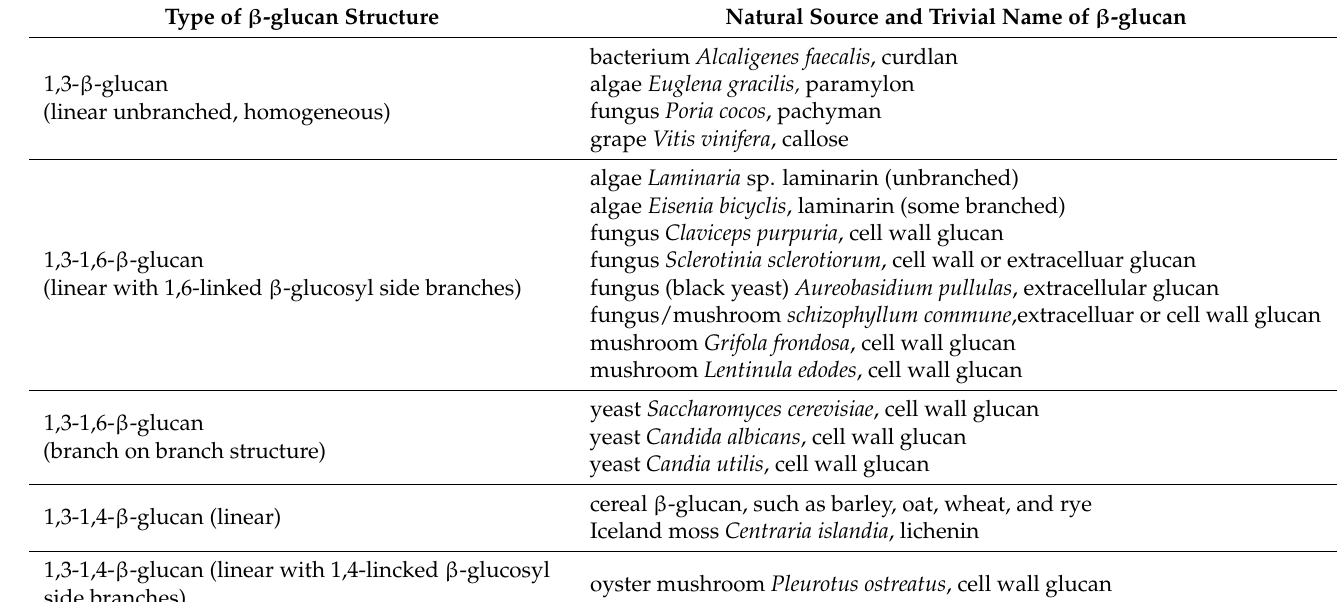
Table 1. Some types of β -glucan with different structures derived from different natural